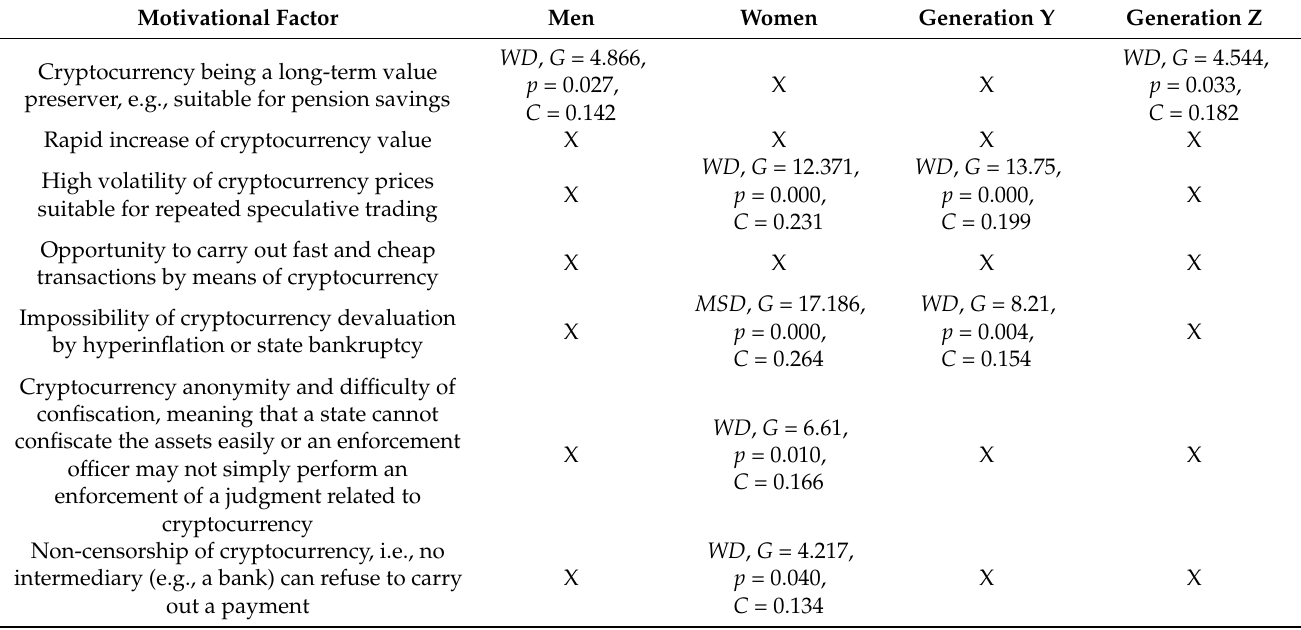
Table 5. The table shows the statistically significant dependence of individual motivational factors with respect to the tendency to take risks and generations or sex. MSD = moderately strong dependence; WD = weak dependence. Motivational